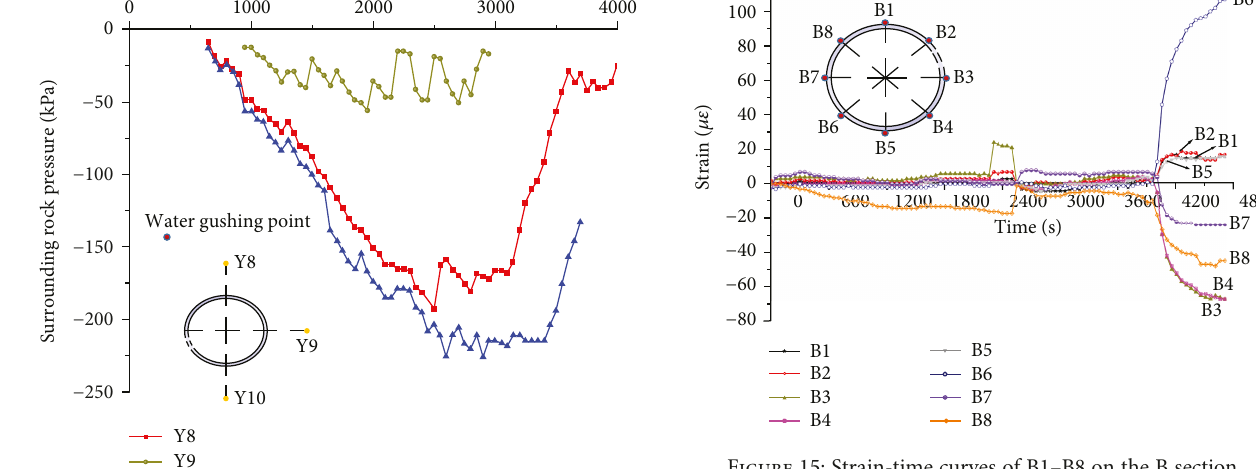
Figure 15: Strain-time curves of B1 – B8 on the B section.